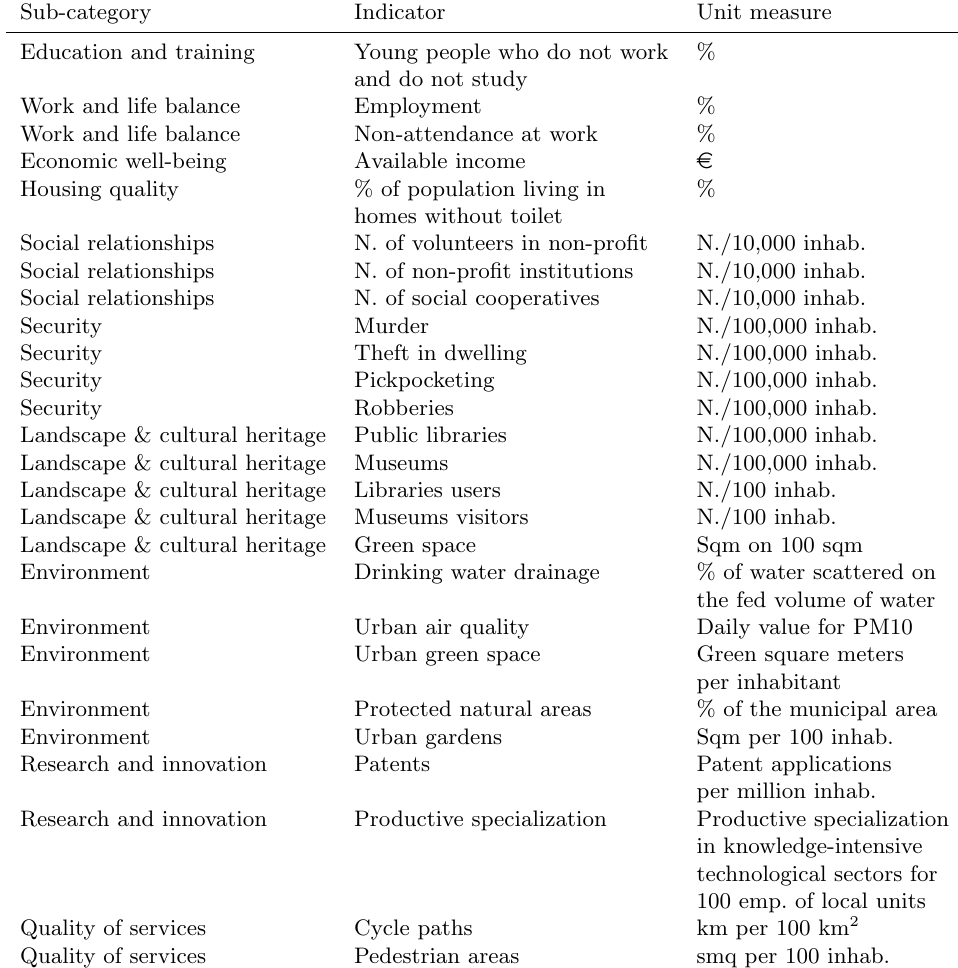
Table 6: Wellbeing indicators associated to cultural heritage